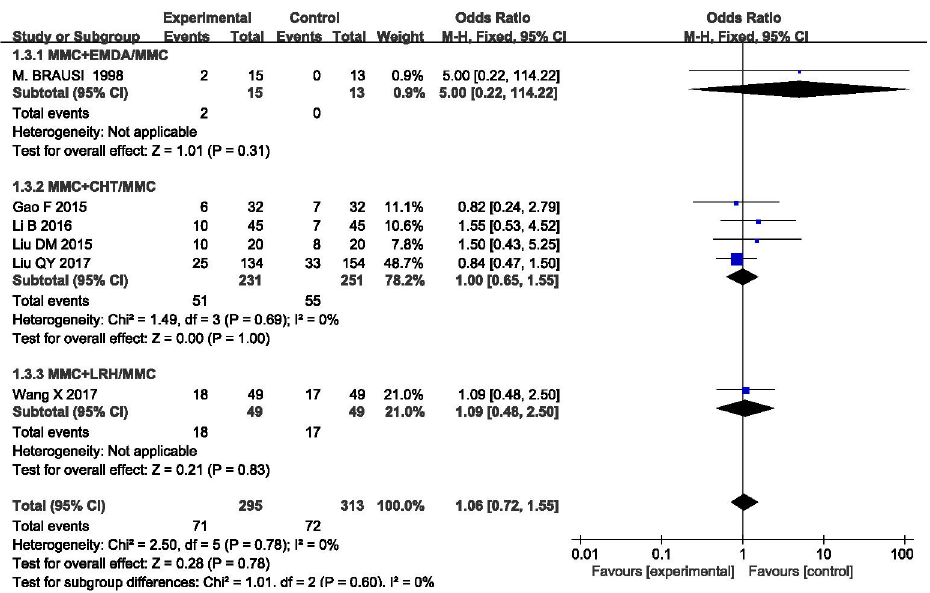
Fig 7. Forest plots for the meta-analysis of the bladder irritation by the different